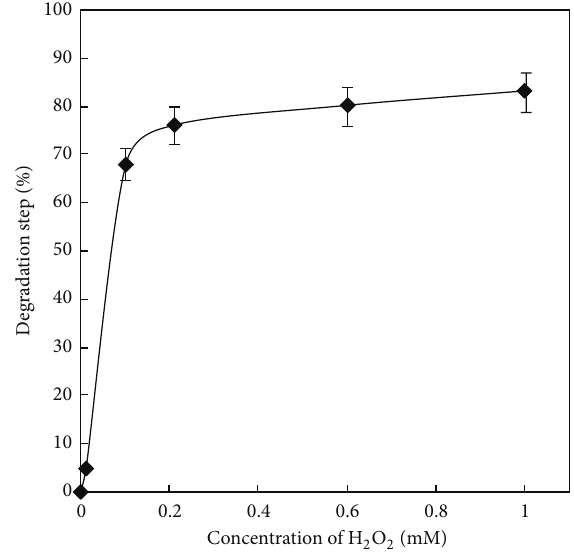
Figure 4: Effect of H 2 O 2 concentration on the step of degradation, 𝑆 𝐷 , of p -HBA.